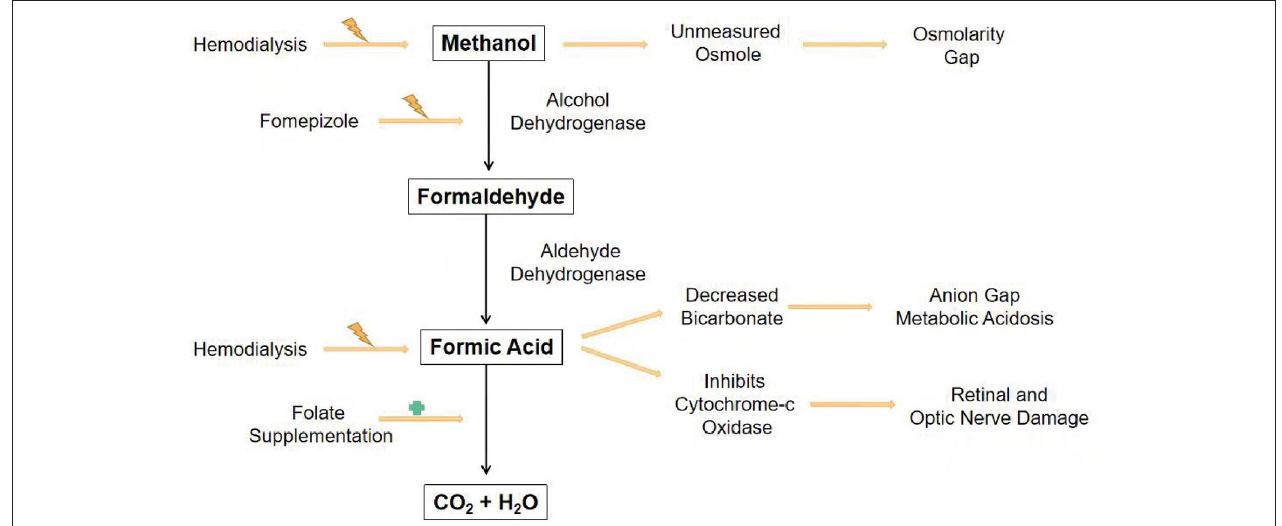
FIGURE 3 | Simplified diagram of the methanol pathway with the resulting signs and interventions.